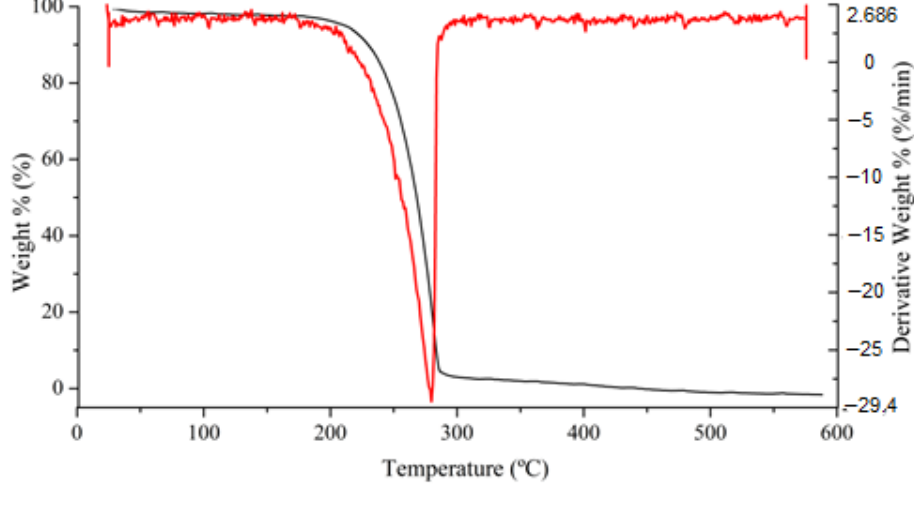
Figure 6. TGA and DTG of BBP.